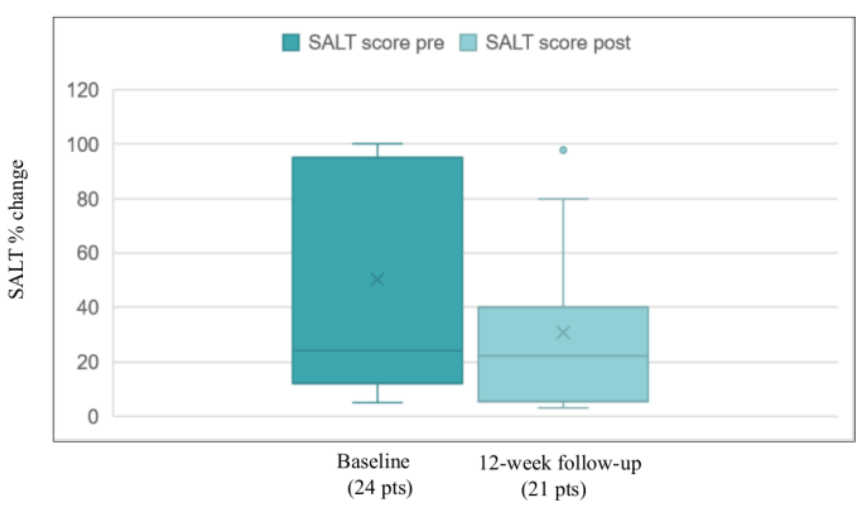
Figure 1. Pre – post-treatment assessment of SALT score: change in the mean value from 43.4 (5 – 100) Figure 1. Pre–post-treatment assessment of SALT score: change in the mean value from 43.4 (5–100) to 36.6 (3.2 – 97.7) after 12 weeks. to 36.6 (3.2–97.7) after 12